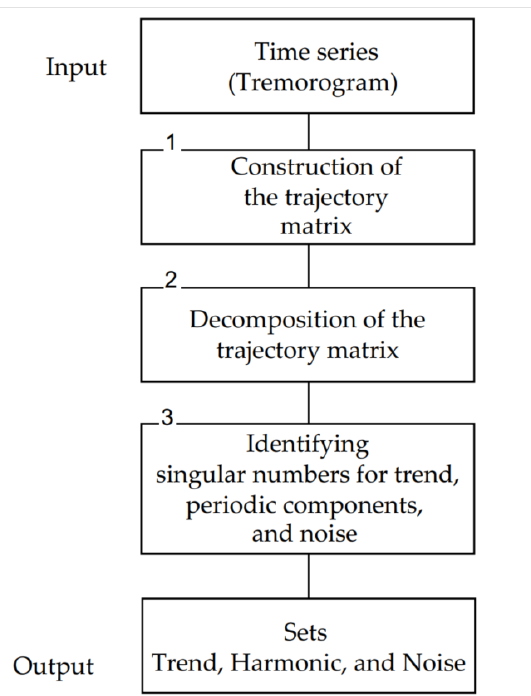
Figure 9. Block diagram representing the main stages of the tremorogram analysis.